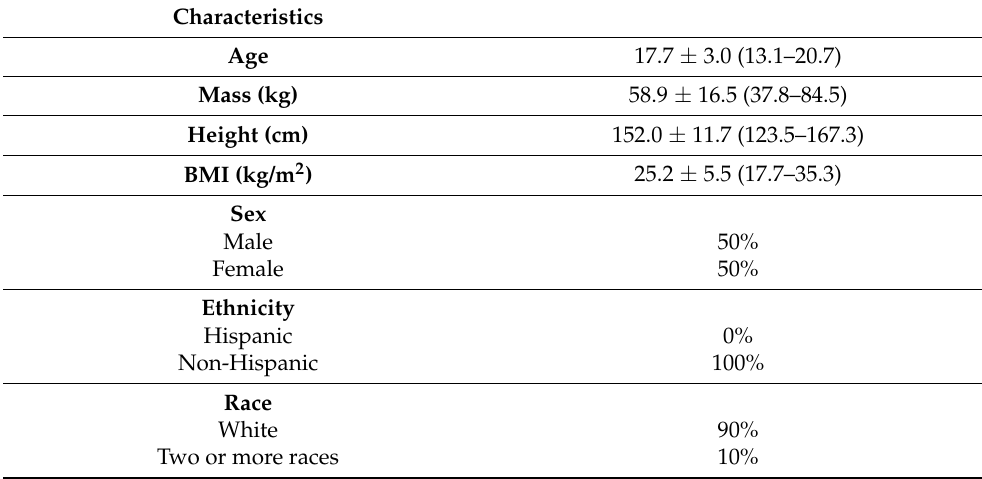
Table 2. Descriptive characteristics ( n = 10; mean + SD; range).